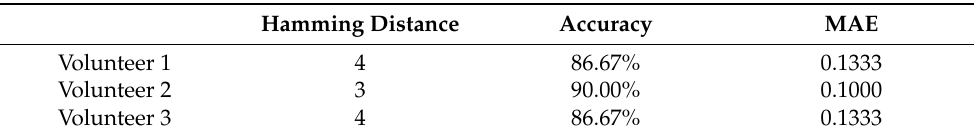
Table 3. Results of the testing hamming distance, accuracy, and mean absolute error MAE of hidden Markov model.